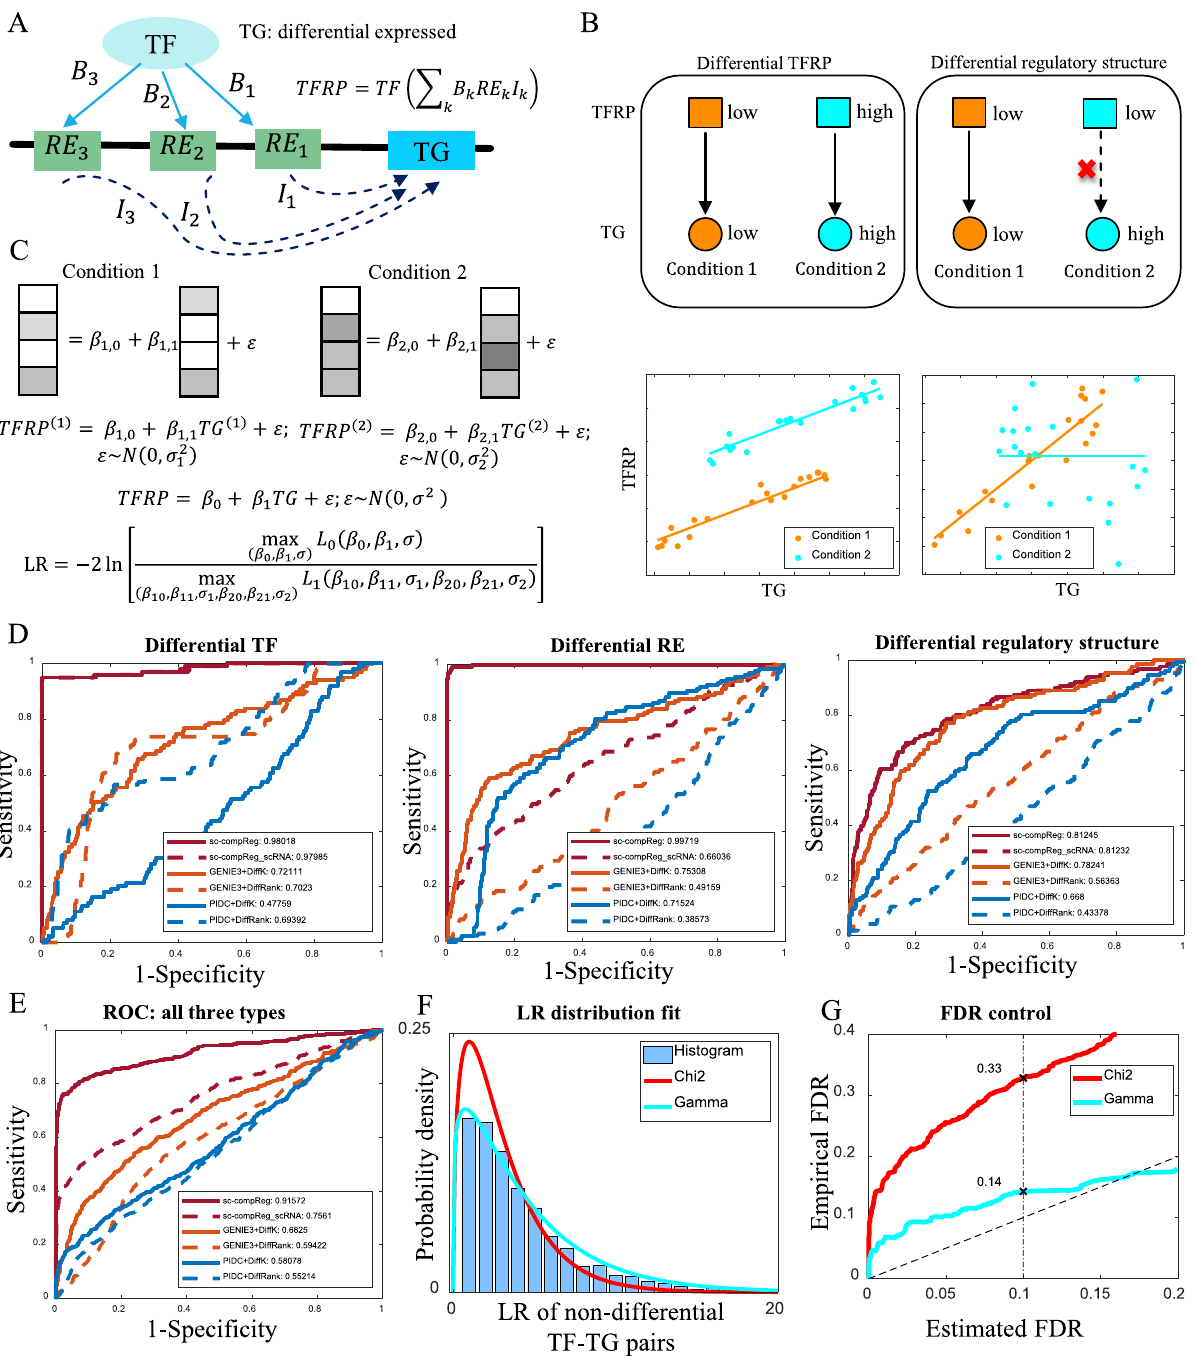
Fig. 2 Concept and validation of sc-compReg. A Concept of TF regulatory potential (TFRP). Here TF indicate TF expression, RE k is the accessibility of the k -th RE, B k -th RE, and I k -th RE is linked to the TG in the k indicates the TF-motif matching strength in the k is an interaction strength for whether the subpopulation-speci fi c regulatory network (constructed in a preceding step in the sc-compReg pipeline. B Two types of differential regulations: differential TFRP (left) and differential regulatory structure (right). C Comparison of the conditional distribution of TFRP given TG expression by the likelihood ratio, for detail please see “ Statistical test for differential regulatory relations ” in the “ Methods ” section. D ROC curves of differential regulatory detection on three simple scenarios of simulation data: differential TF expression, differential RE accessibility, and differential regulatory network structure. For simulation detail please see “ Differential regulatory network data simulation ” in the “ Methods ” section. E ROC curves of differential regulatory detection on simulation data containing all three types of differential regulation. F Comparison of likelihood ratio distribution with chi-square distribution and Gamma distribution. G Comparison of estimated FDR with the empirical FDR.